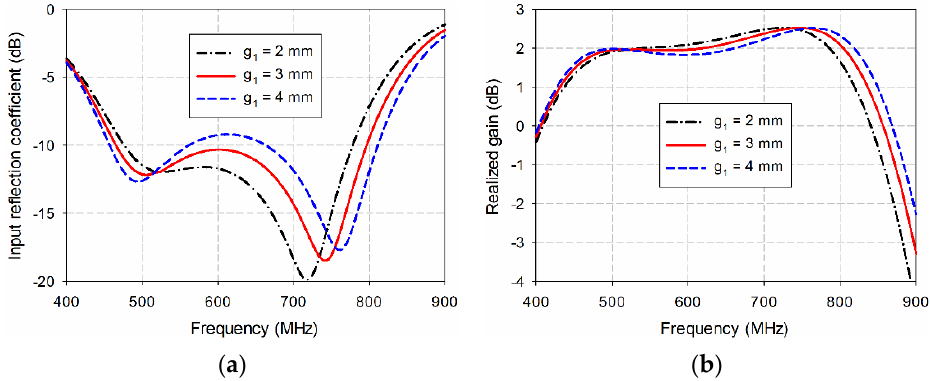
Figure 7. Effects of varying w c on the performance of the proposed antenna: ( a ) the input reflection coefficients, ( b ) the realized gain.